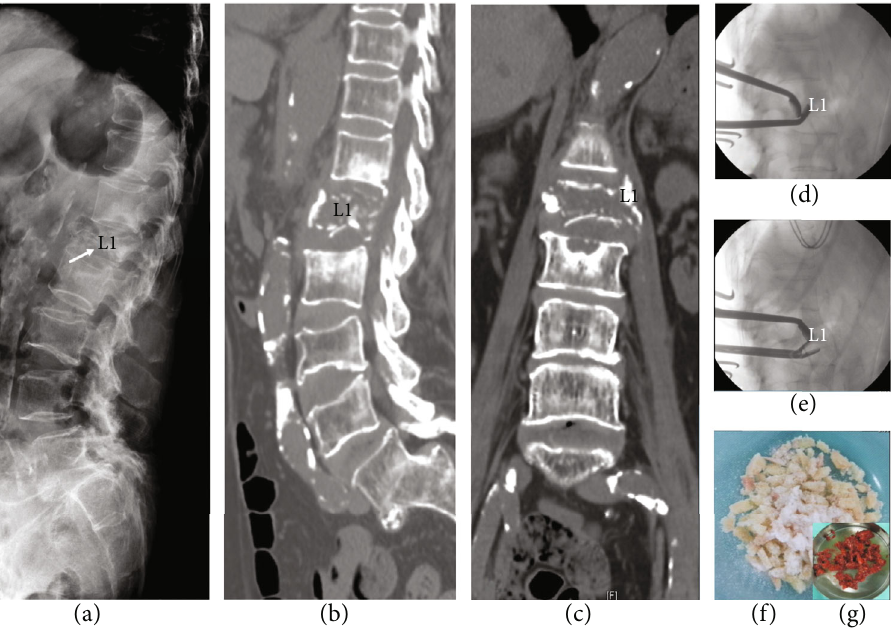
Figure 1: (a) Lateral radiograph and (b) axial and (c) coronal CT reconstructions showed a collapsed nonhealing L1 vertebral body with destruction of both upper and lower endplates. (d, e) T11/T12 and T12/L1 transforaminal debridement using curettes to remove disc material and cartilage. (f) Antibiotic impregnated allograft. (g) Autologous bone graft from posterior iliac